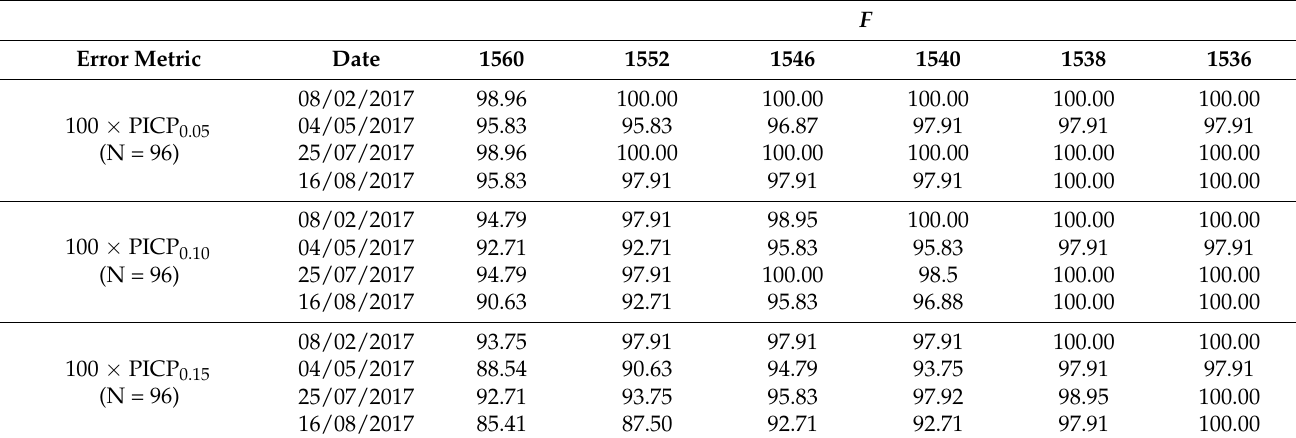
Table 9. PICP α results for computed scenarios ( F , α )